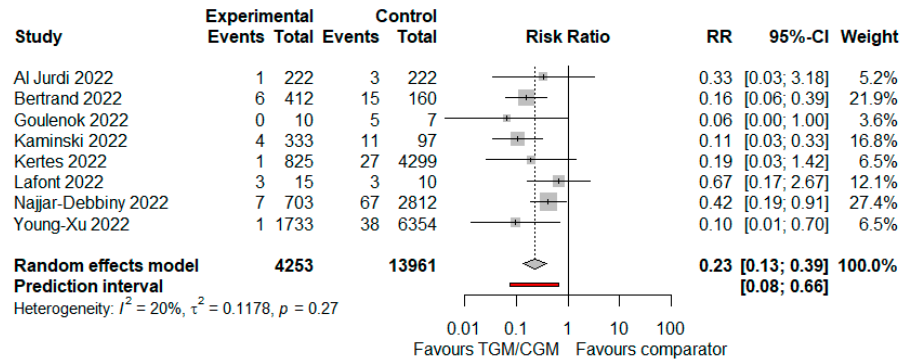
Figure 6. Rate of COVID-19-related hospitalization (TGM/CGM vs. comparator). CI, confidence interval; RR, risk ratio; TGM/CGM, tixagevimab/cilgavimab.